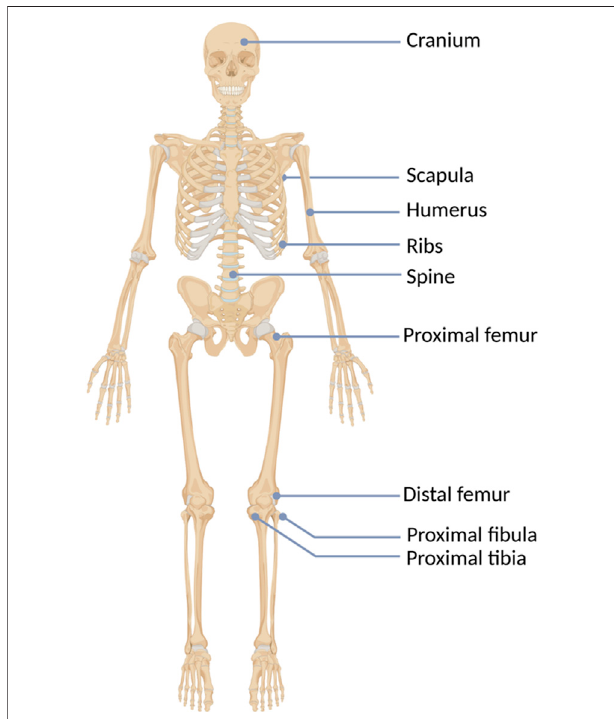
FIGURE 2 | The hereditary multiple exostoses (HMEs) localization in the human skeleton.